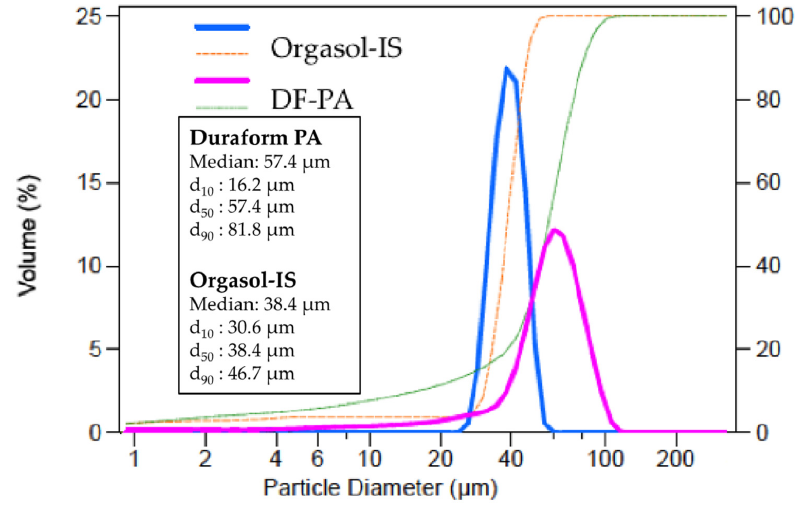
Figure 8. Comparison of volume distribution of DF ‐ PA and Orgasol ‐ IS by laser diffraction.